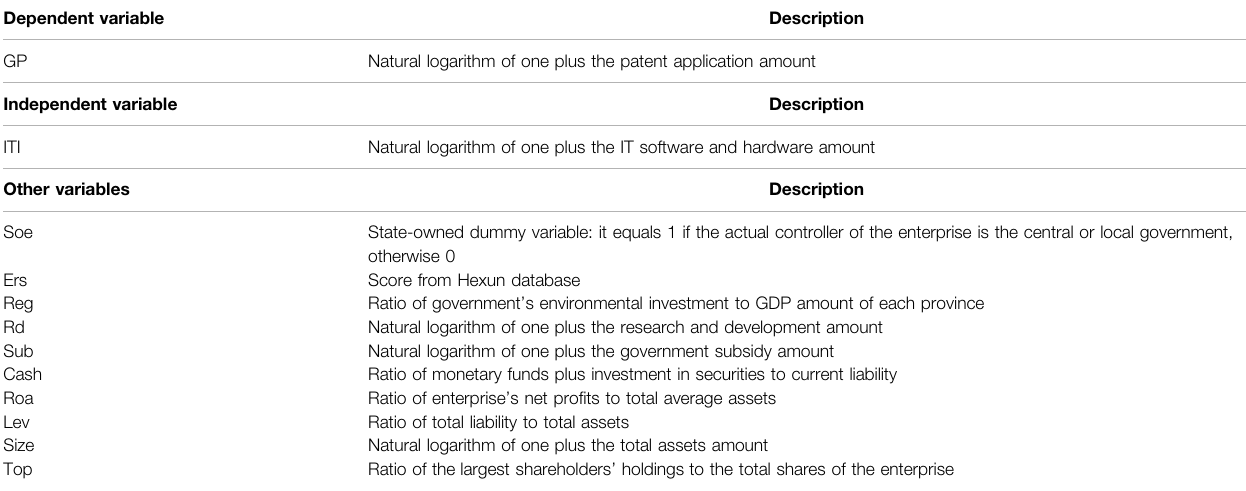
TABLE 1 | Variable de fi